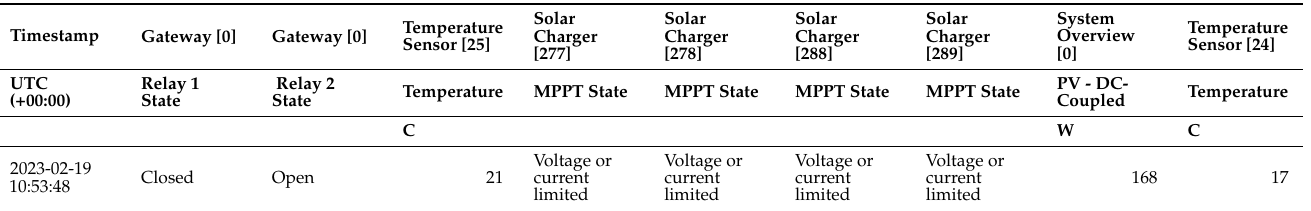
Table 6. Capture in test based on high-temperature alarms in the inverter using Temperature Sensor 25, acting on Relay